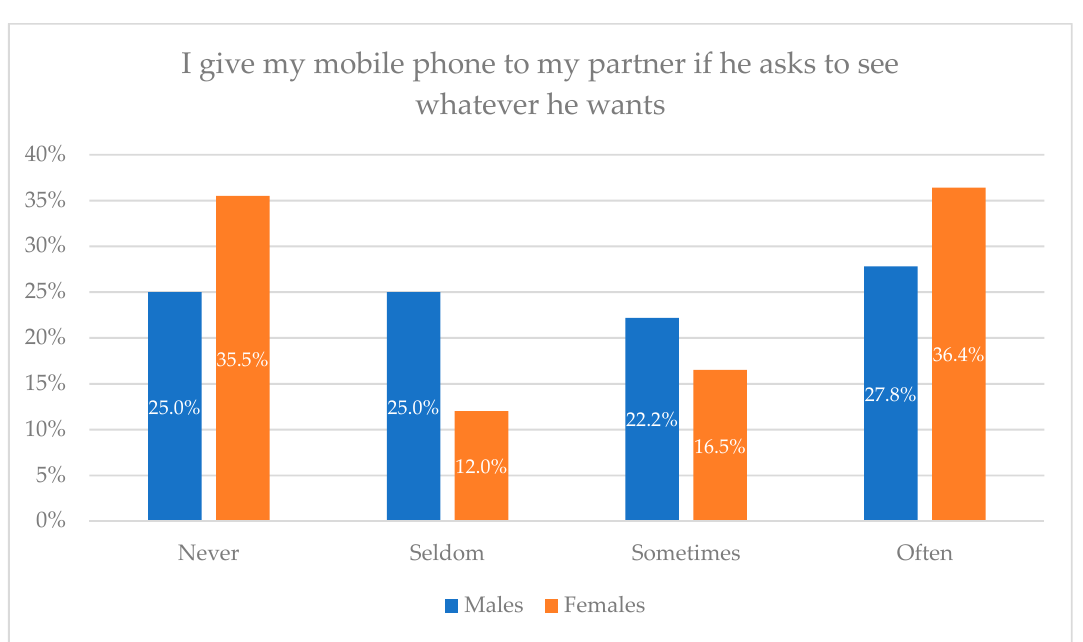
Figure 3. Results of item 71 on affective–sexual relationships according to the gender of the participants.